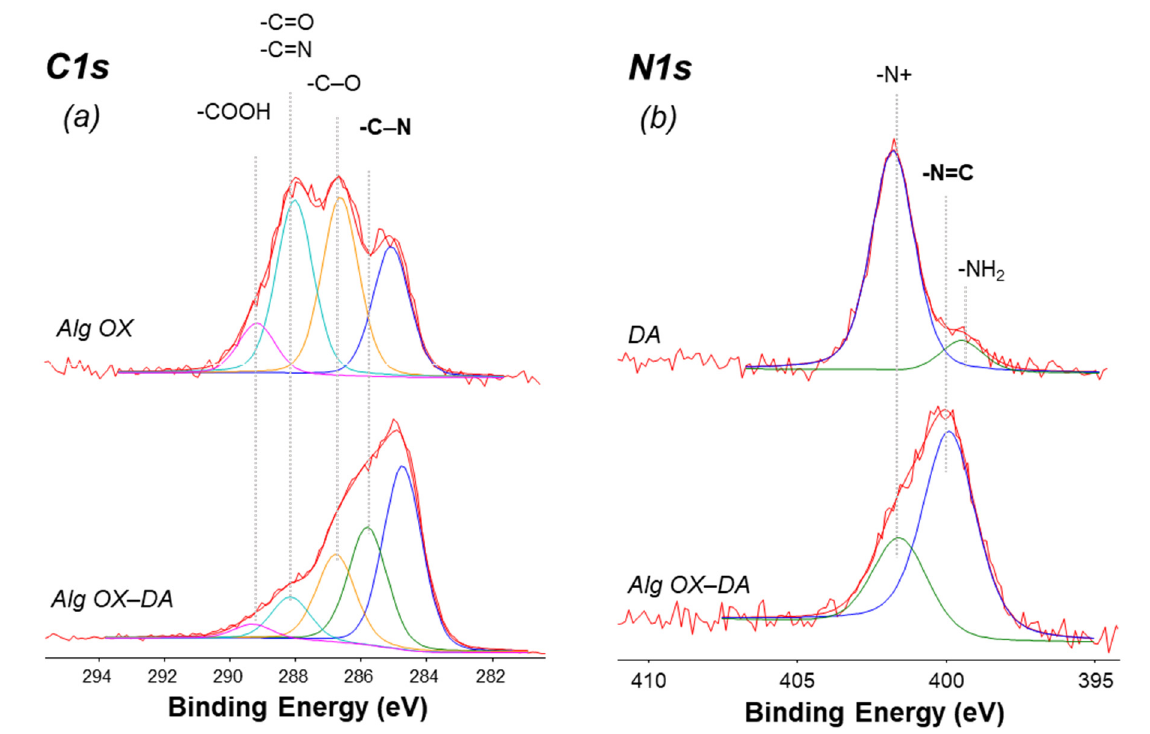
Figure 9. ( a ) C1s curve fitted XP spectrum of AlgOX and AlgOX-DA imine conjugate; ( b ) N1s curve fitted XP spectrum of DA and AlgOX-DA imine conjugate. Peak component attribution is reported for all the spectral regions. Table 1. XPS surface elemental percentages for DA, AlgOX, and AlgOX-DA Schiff base. The values are indicated as mean values averaged from at least three replicates; the errors are expressed as standard deviation ± 1 S. Sample